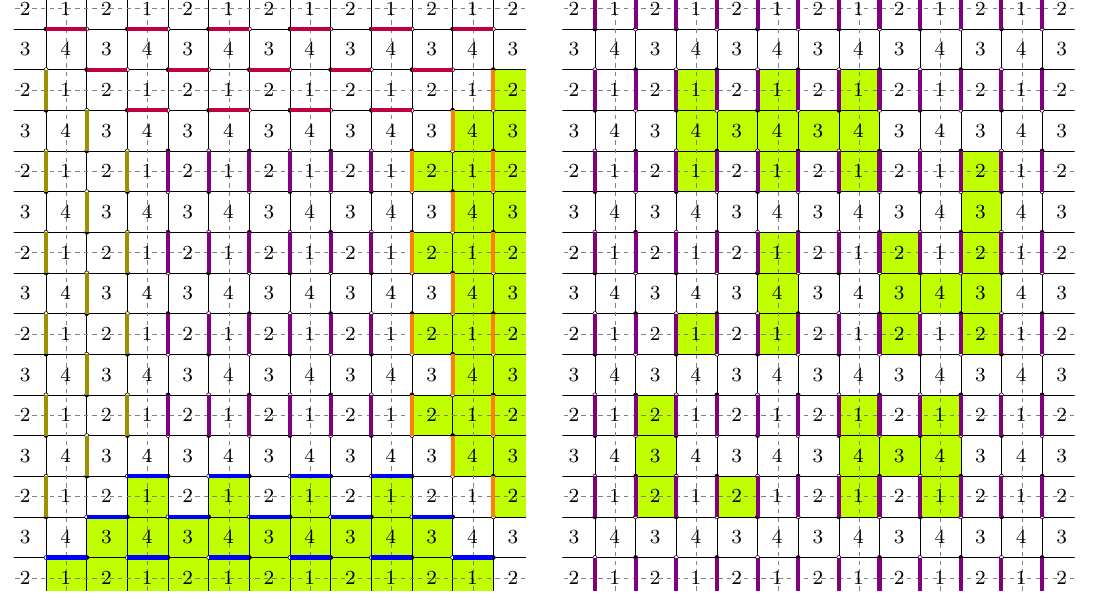
( N + 1 , M + 1) and ( N, M ) 7→ 7→